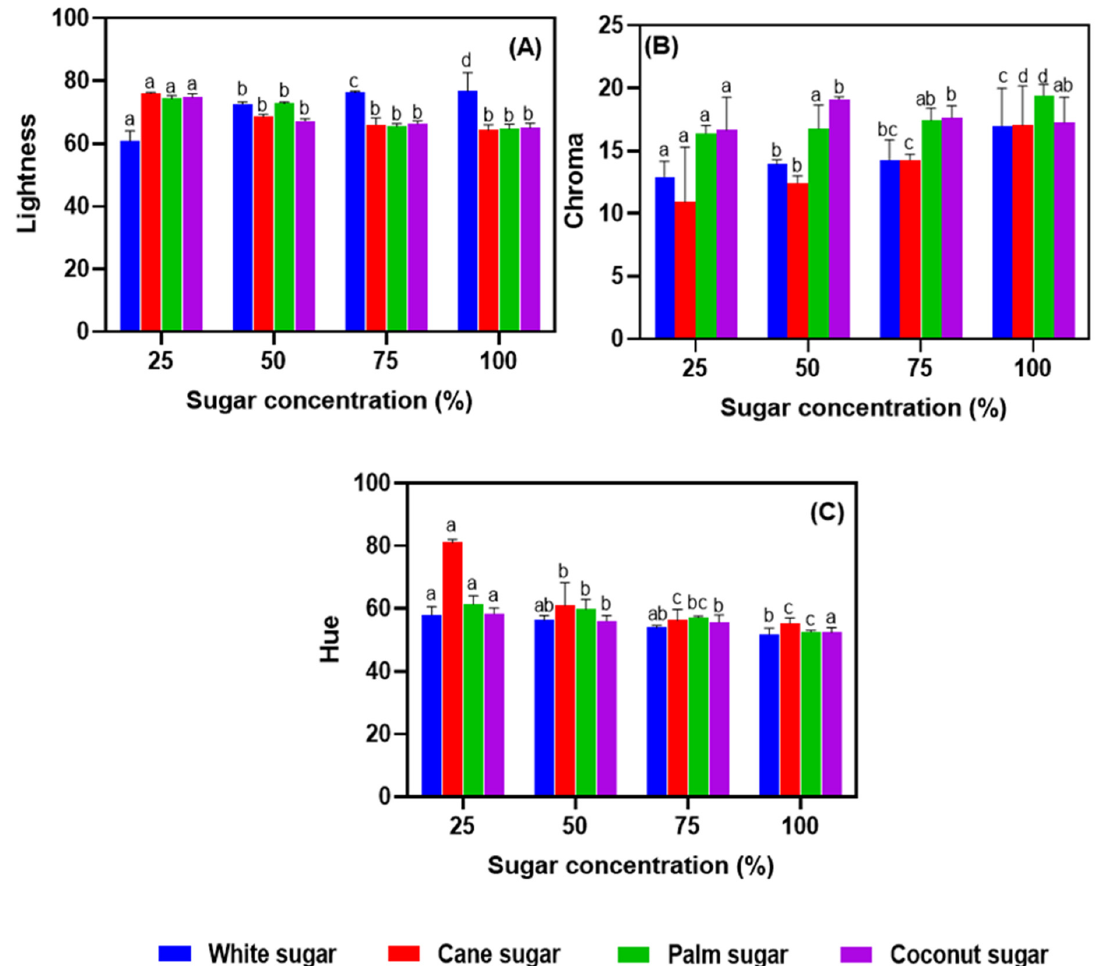
Figure 3. Color profile (lightness ( A ), chroma ( B ), and hue ( C )) of salted duck egg white meringues above the bars indicate significant differences among various